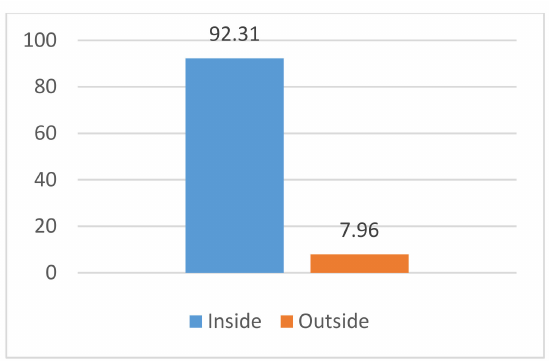
Figure 13. Relative amount of tracks that are contained within the previously calculated directional corridors for each cell in the